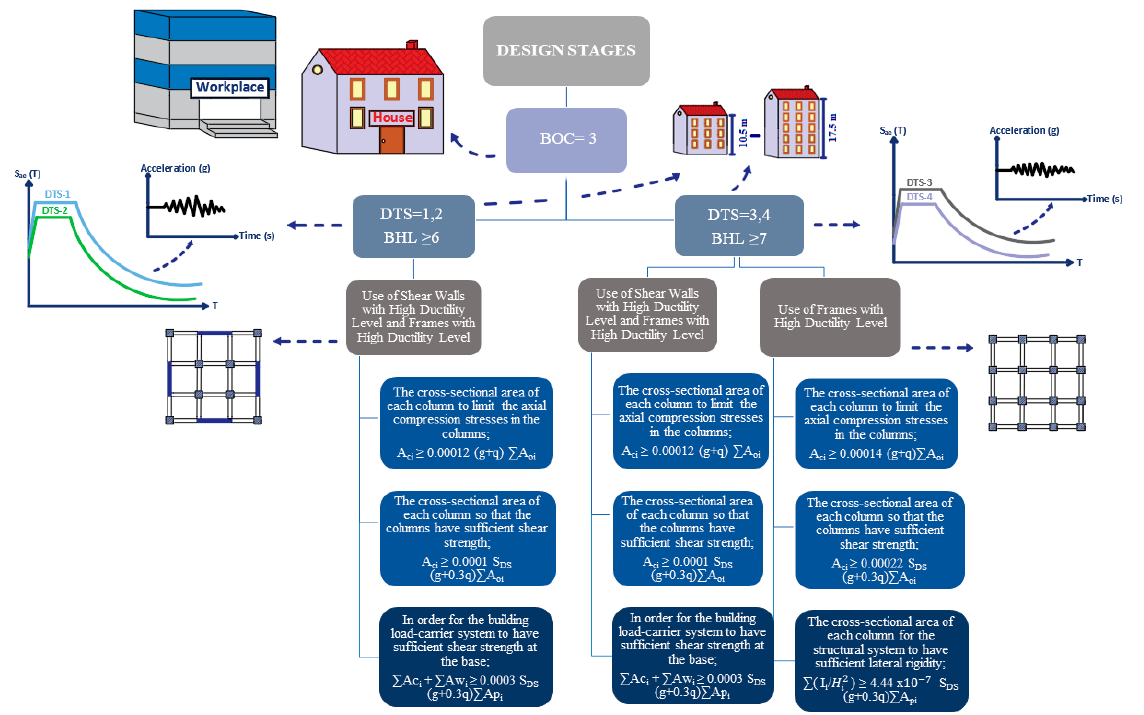
Figure 3. Simplified calculation procedure in TBEC-2019.